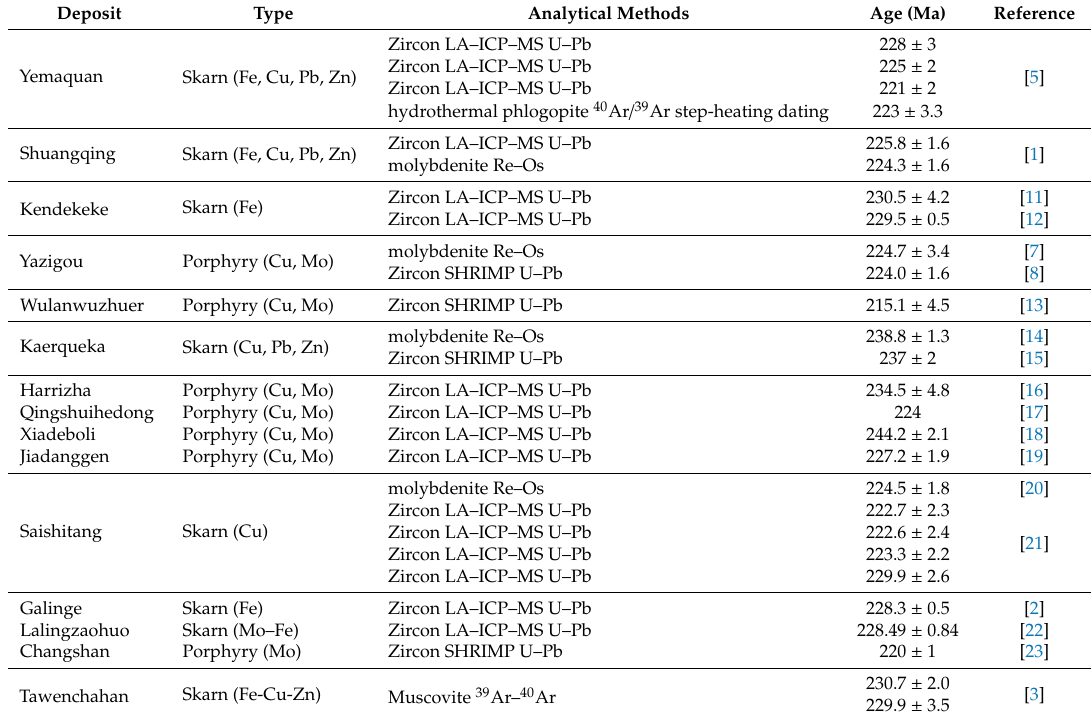
Table 1. Magmatic and mineralization ages for porphyry-skarn polymetallic deposits of the